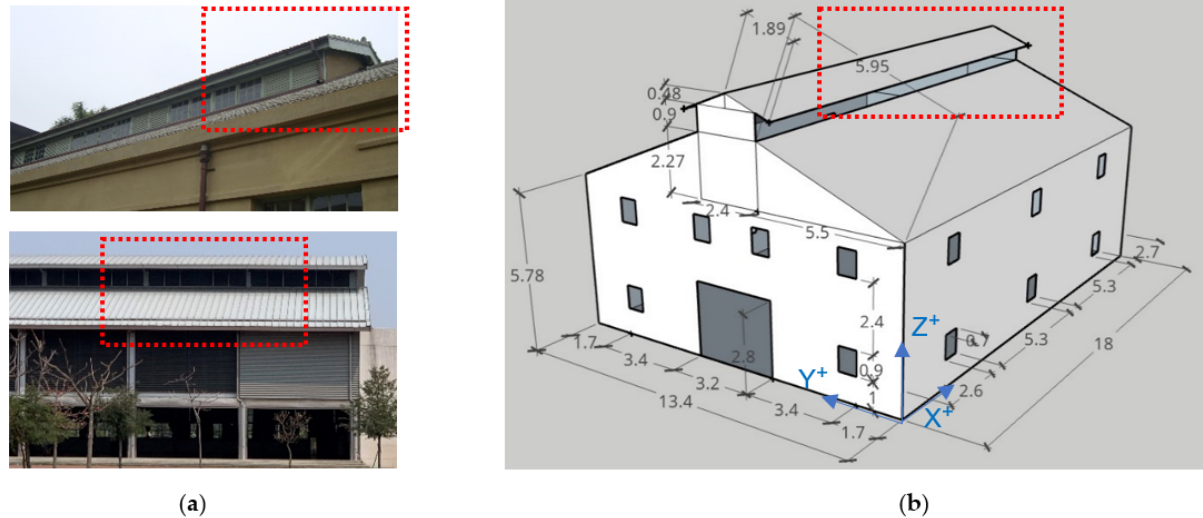
Figure 1. Building design cases with ridge vents (red dotted area) (unit: m). ( a ) Field images, ( b ) A Factory case and its dimensions.